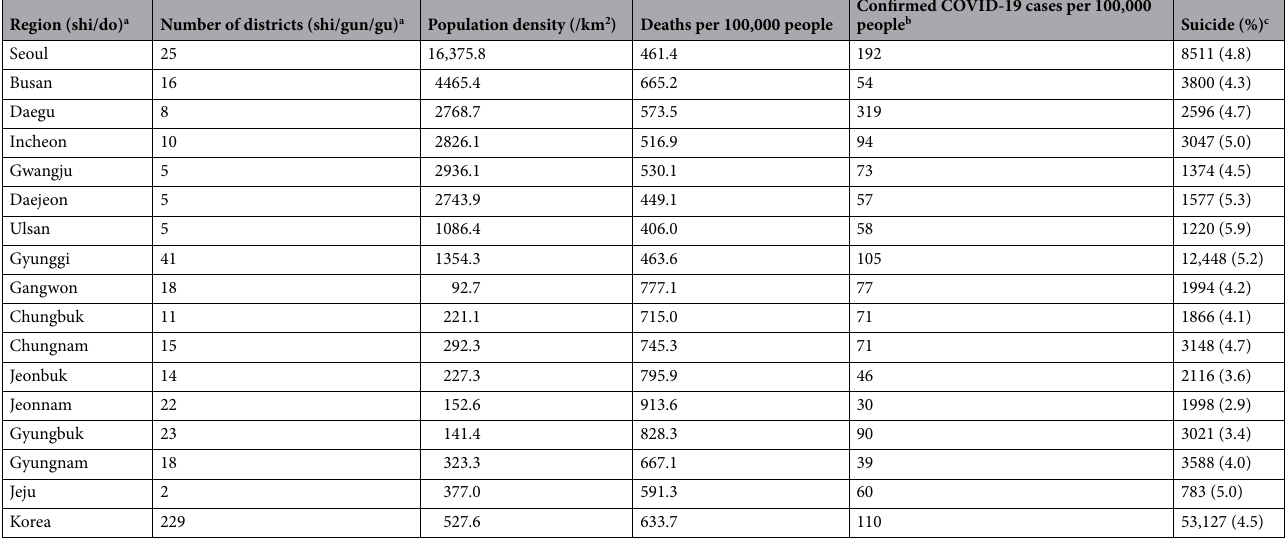
Table 1. Characteristics of the 16 regions in Korea within the study period (January 1, 2017–December 31, 2020). a The 16 regions (shi/do) is the first-level administrative region of Korea and the 229 districts (shi/ gun/gu) is the second-level administrative region in Korea. b Confirmed COVID-19 cases per 100,000 people indicates the cumulative COVID-19 confirmed cases during the period January 20–December 31, 2020. c Proportion of suicide was calculated by dividing the number of suicide deaths by the number of total deaths for the study